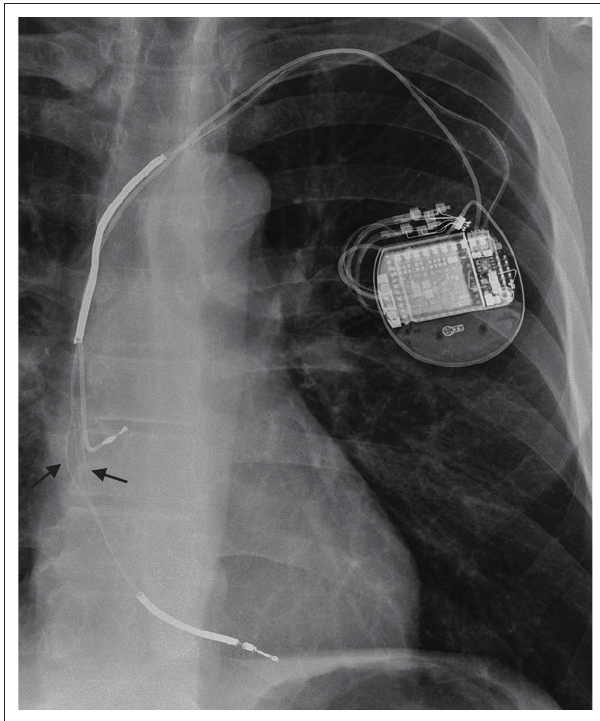
FIGURE 10: A dual-lead implantable cardioverter defibrillator showing externalised conductors (arrows) of its right ventricular lead, leading to its